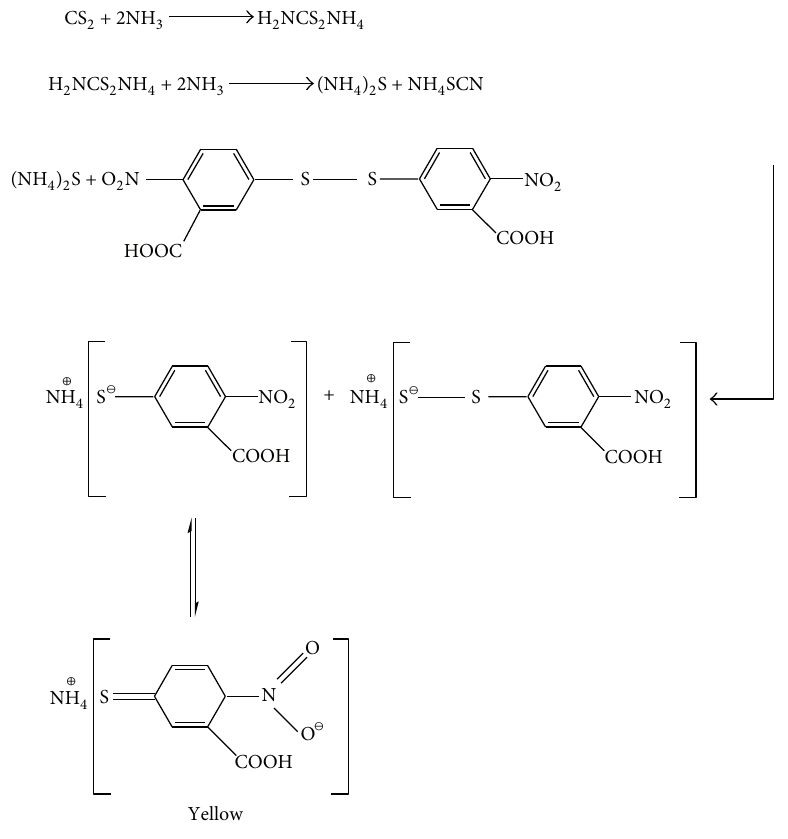
F 1: Scheme of analytical reaction (with DTNB).